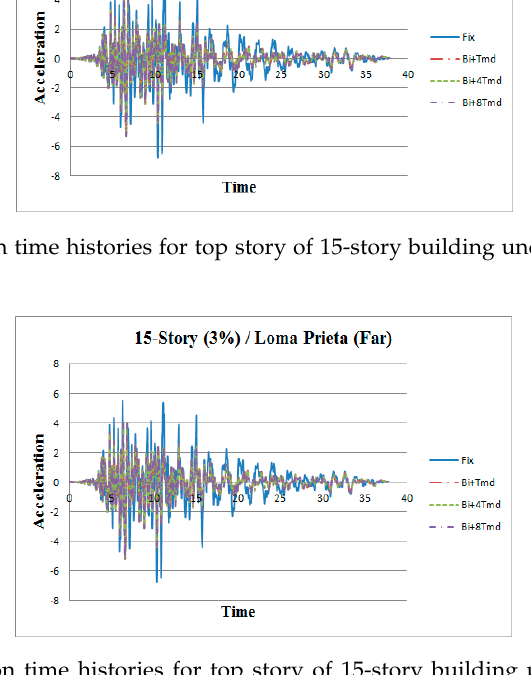
Figure A2. Acceleration time histories for top story of 15-story building under the Loma Prieta (far-fault) earthquake.